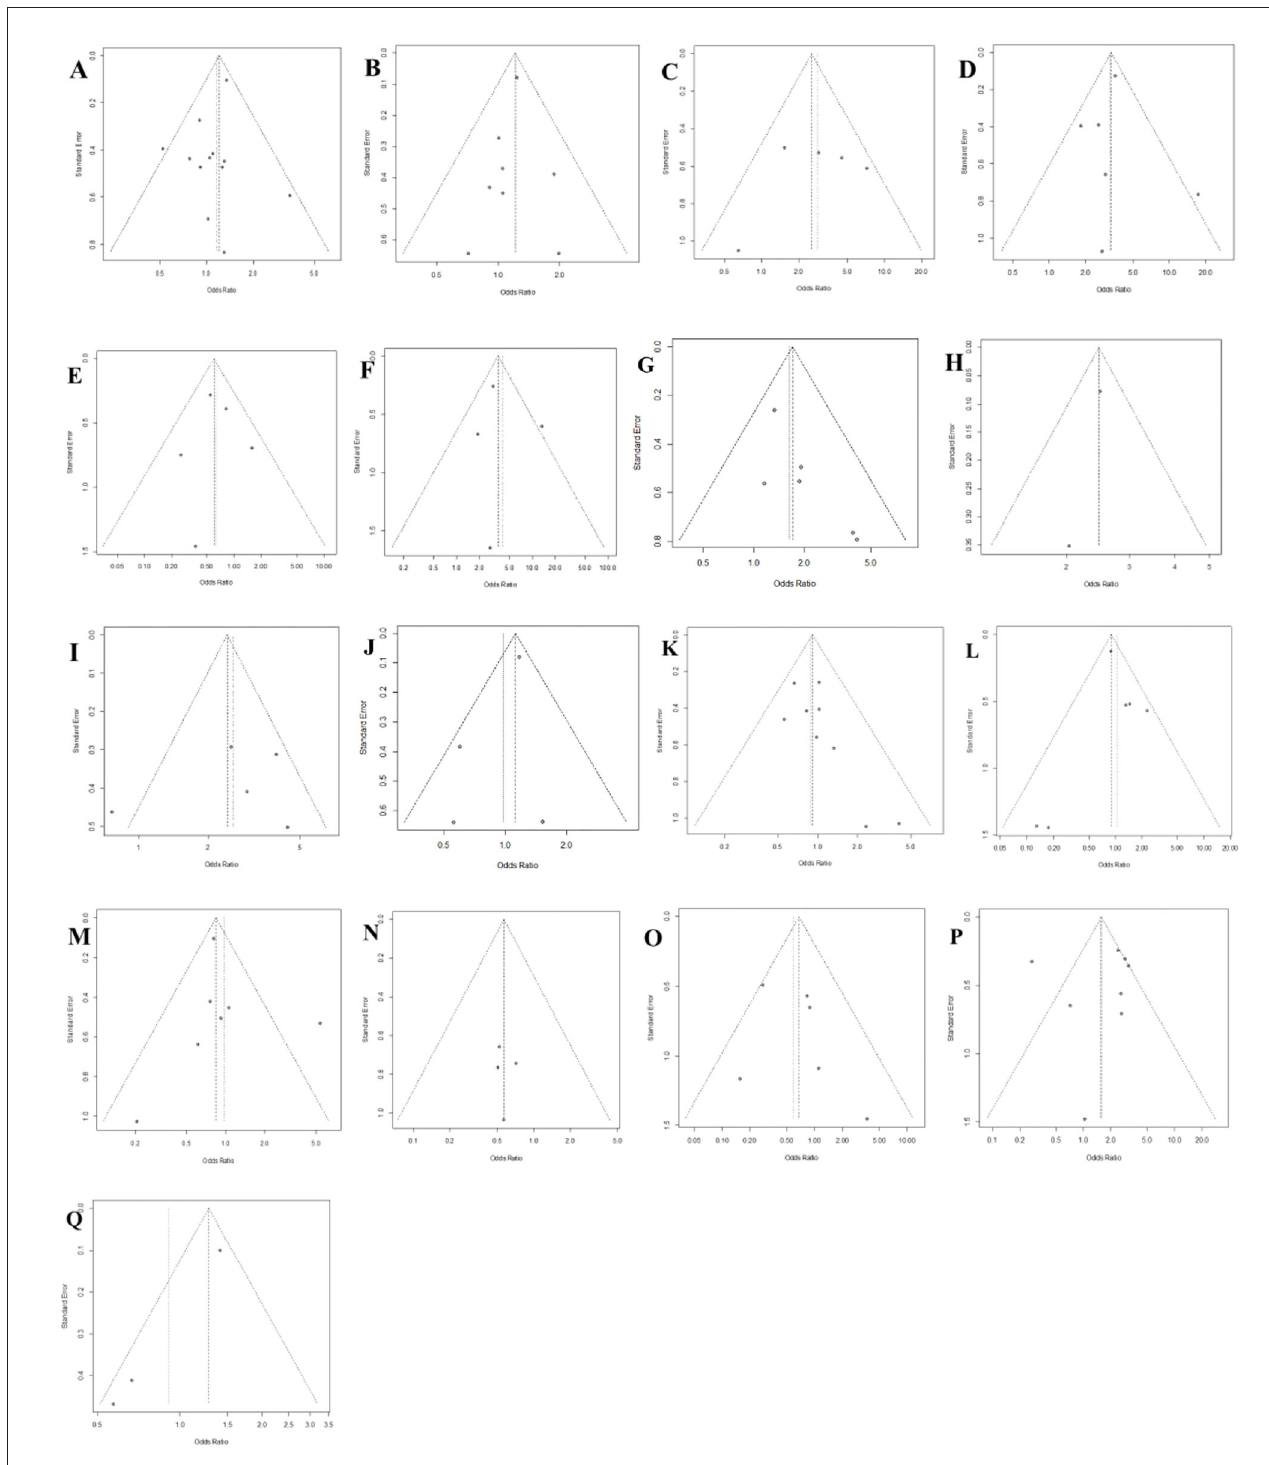
FIGURE 4 | Funnel plot of publication bias in the meta-analysis. (A) Sex; (B) Diabetes; (C) Extended hemihepatectomy; (D) Central hepatectomy; (E) Liver cirrhosis; (F) Left trisectionectomy; (G) Anatomical hepatectomy; (H) Bleeding; (I) Segment I hepatectomy; (J) Age; (K) Underlying liver disease; (L) Left hepatectomy; (M) Right hepatectomy; (N) Benign disease; (O) Child-Pugh class A/B; (P) Intraoperative blood transfusion; (Q) Pre-operative albumin < 3.5 g/dL.